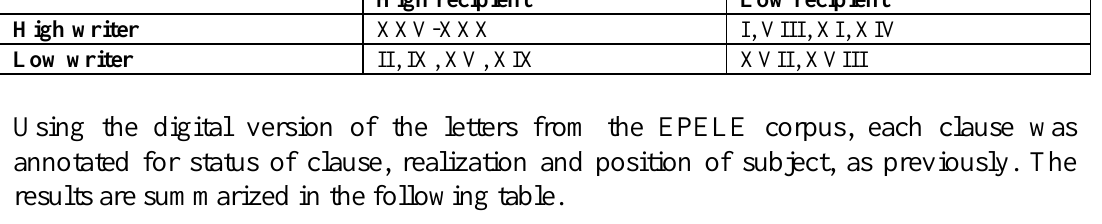
Figure 1. d’Estouteville letters by social class of writer and recipient High recipient Low recipient High writer XXV-XXX I, VIII, XI, XIV Low writer II, IX, XV, XIX XVII, XVIII